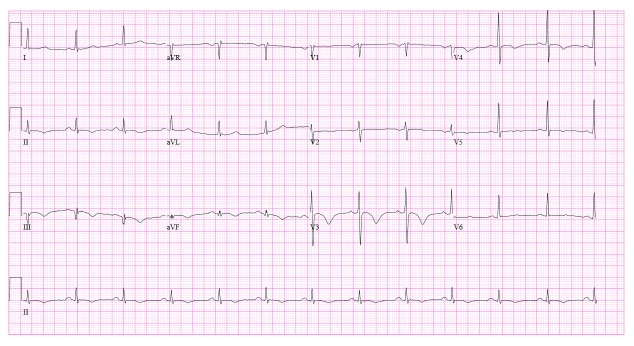
Repeat EKG now showing a Q
3T
3 pattern in lead III.